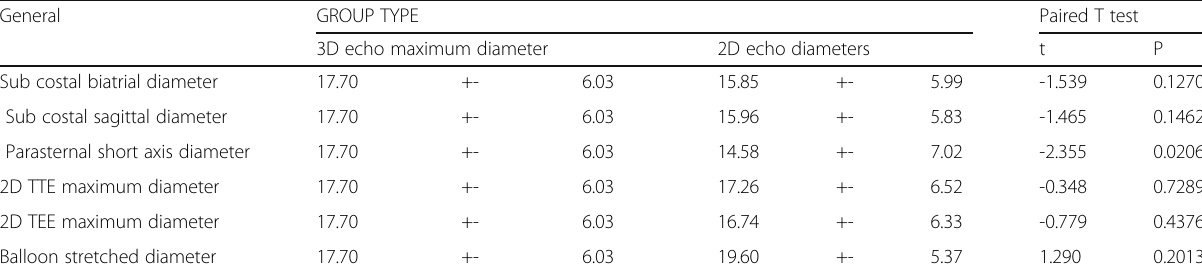
Table 2 univariate analysis of 3D echo maximum ASD diameter versus 2D echo ASD diameters using independent sample T test General GROUP